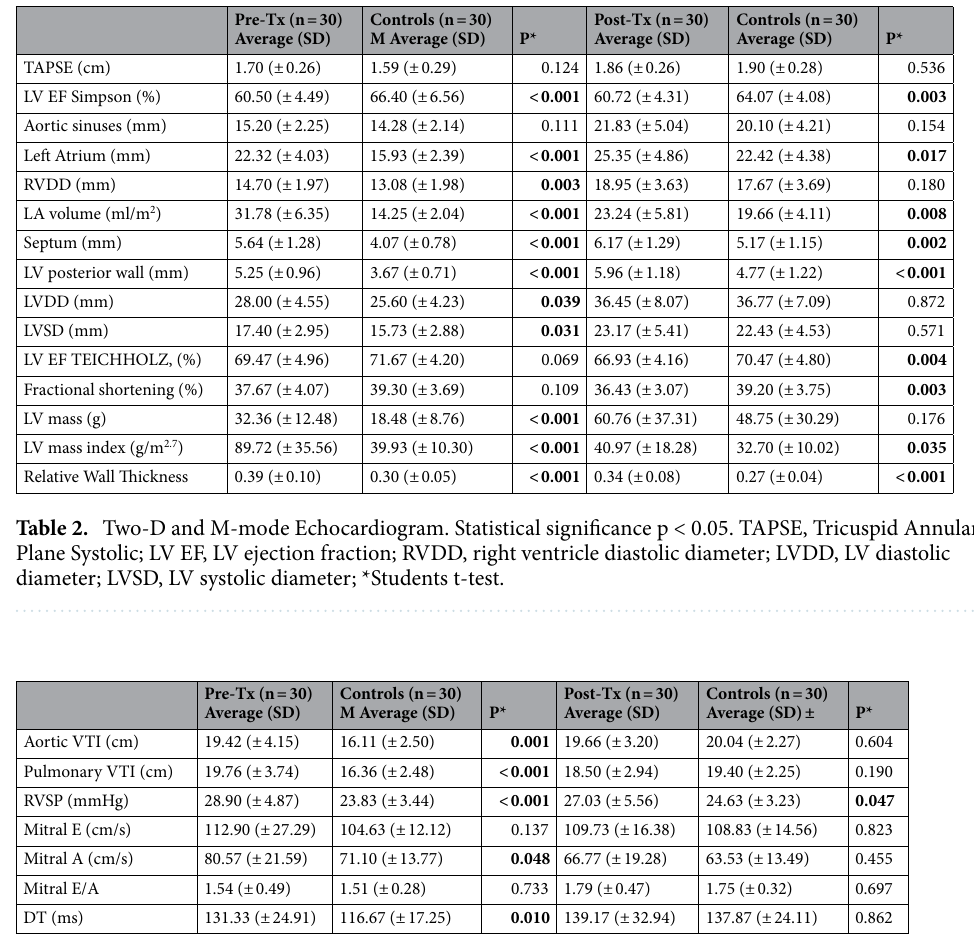
Table 3. Convetional Doppler parameters. Statistical significance p < 0.05. VTI, velocity time integral; RVSP, RV systolic pressure; DT, deceleration time; *Students